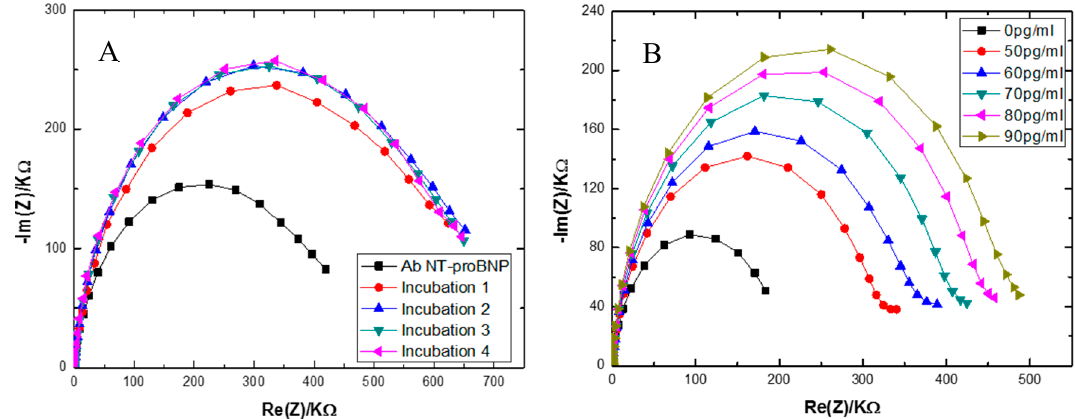
Figure 2. ( A ) EIS analyses for biosensor after several incubations in AS. ( B ) EIS analyses for biosensor after several incubations in AS spiked with different NT-proBNP concentrations (50–90